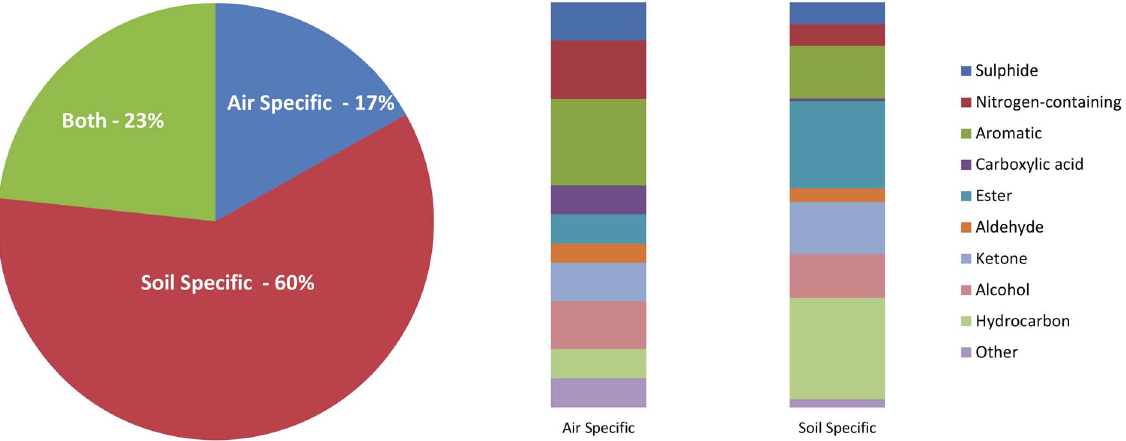
Figure 5. Percentage of total compounds specific to air and soil including dominant classes.